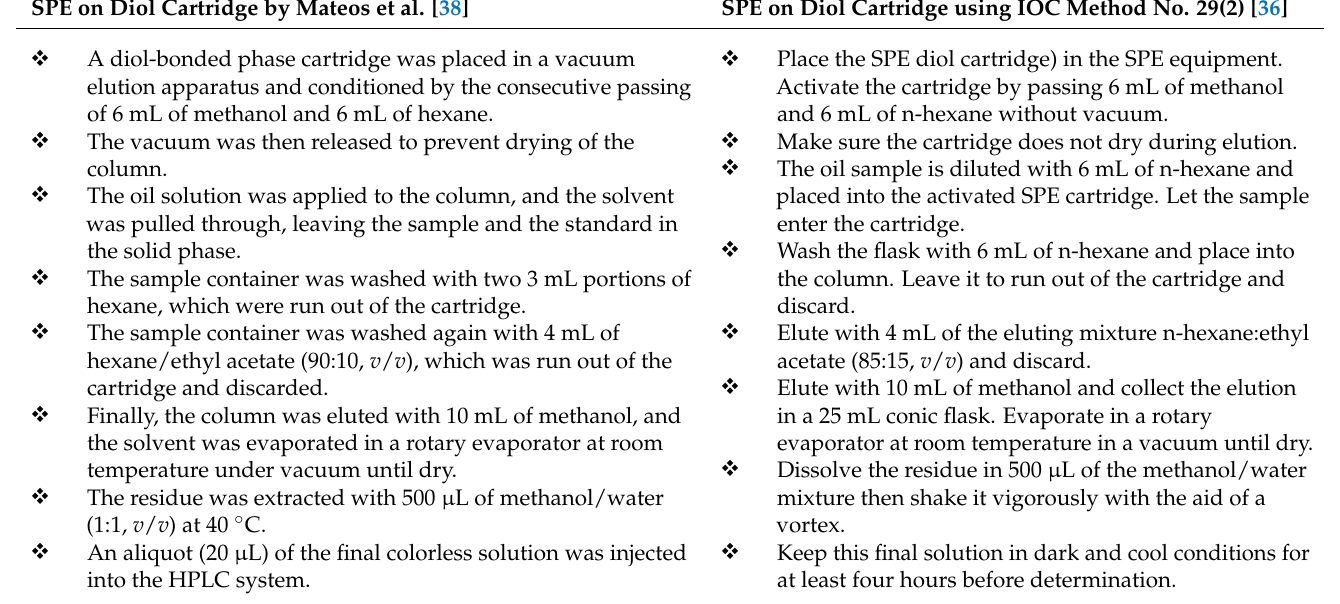
Table 3. SPE conditions proposed for the extraction of the olive oil polar fraction according to